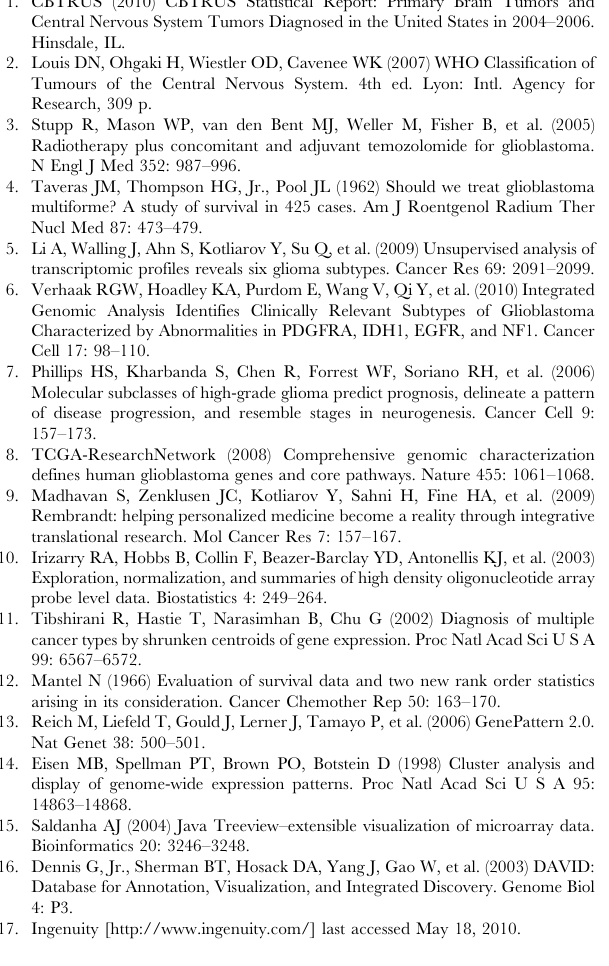
Table S8 Integrated RNA and DNA Copy number analysis comparison of low- and high-grade proneural gliomas.